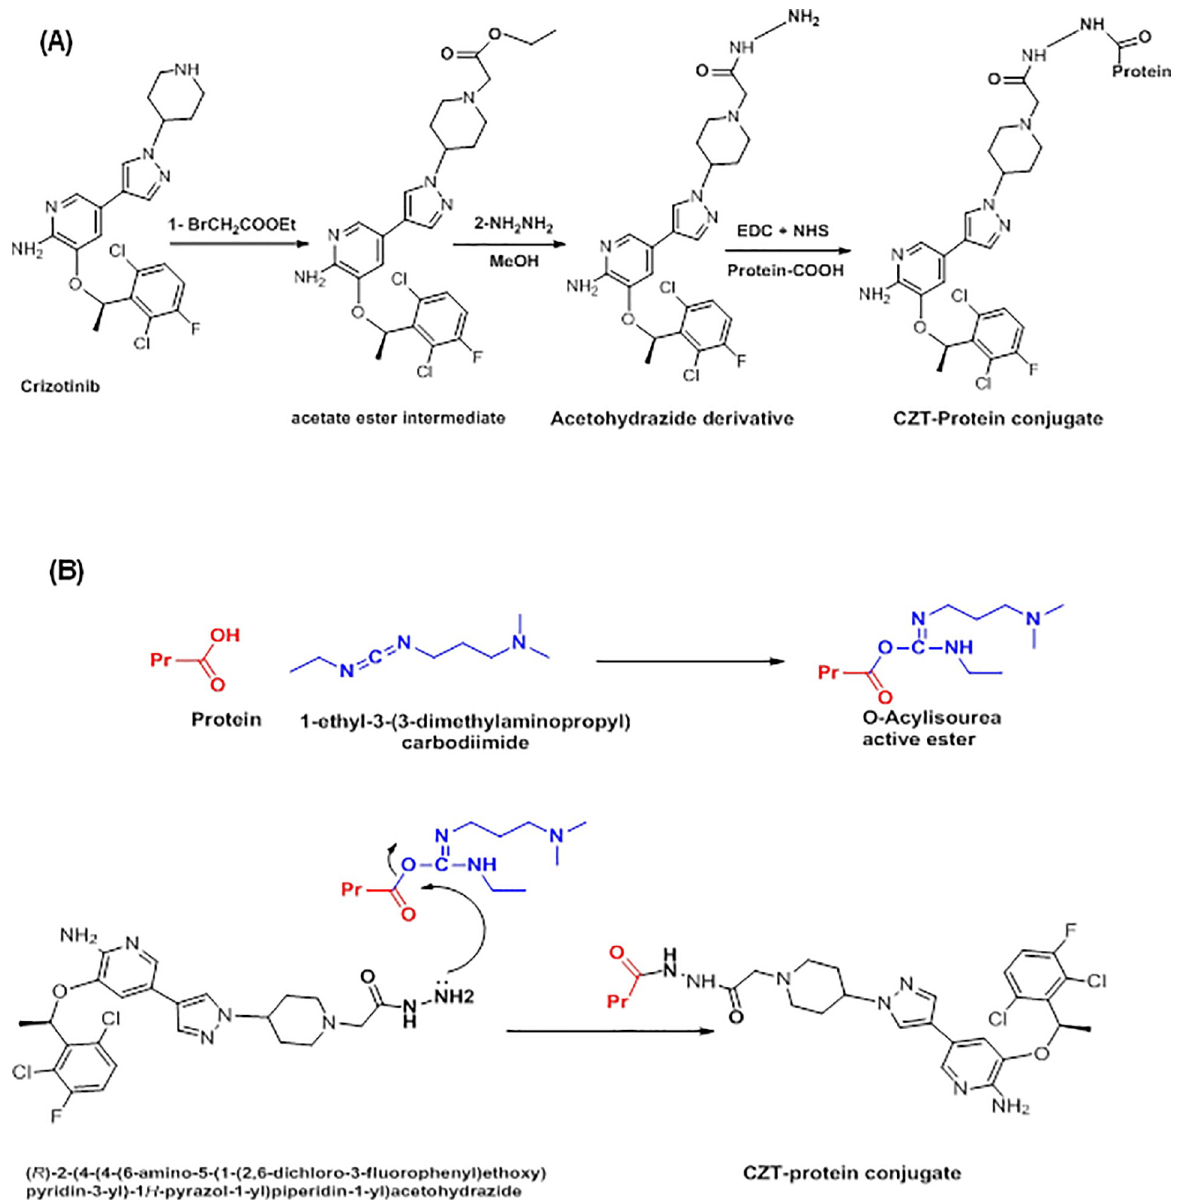
Fig 1. Reaction pathway for synthesis acetohydrazide derivative of CZT and its coupling with proteins (A) and the coupling reaction mechanism (B). Protein-COOH is the BSA and KLH, EDC is 1-ethyl-3-(3-dimethyl-aminopropyl carbodiimide hydrochloride and NHS is N -